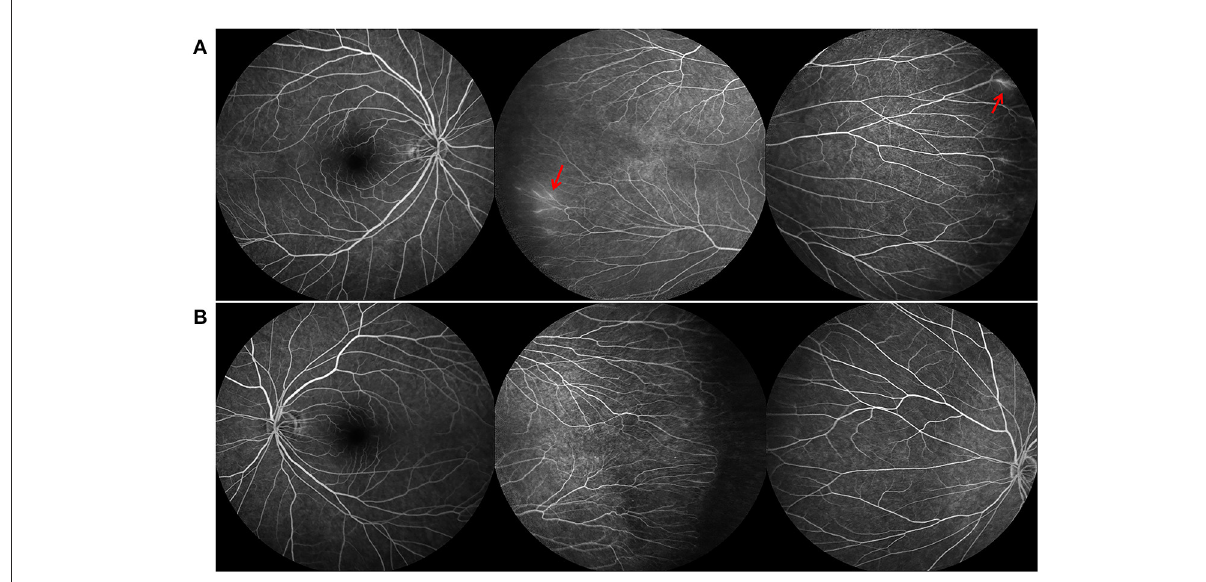
FIGURE2 Fundus fluorescein angiography (FFA) findings of the father of case 1, who also carried the FZD4 mutation. (A,B) are bilateral fundus images, showing temporal avascular area with brush-shaped peripheral retinal vessles and leakage of the dye (red arrow).